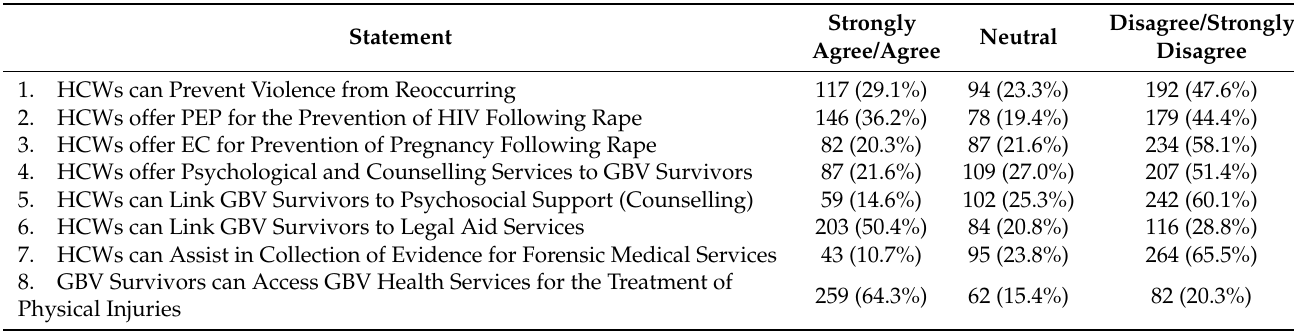
Table 3. Perceptions of and experiences with GBV health services among